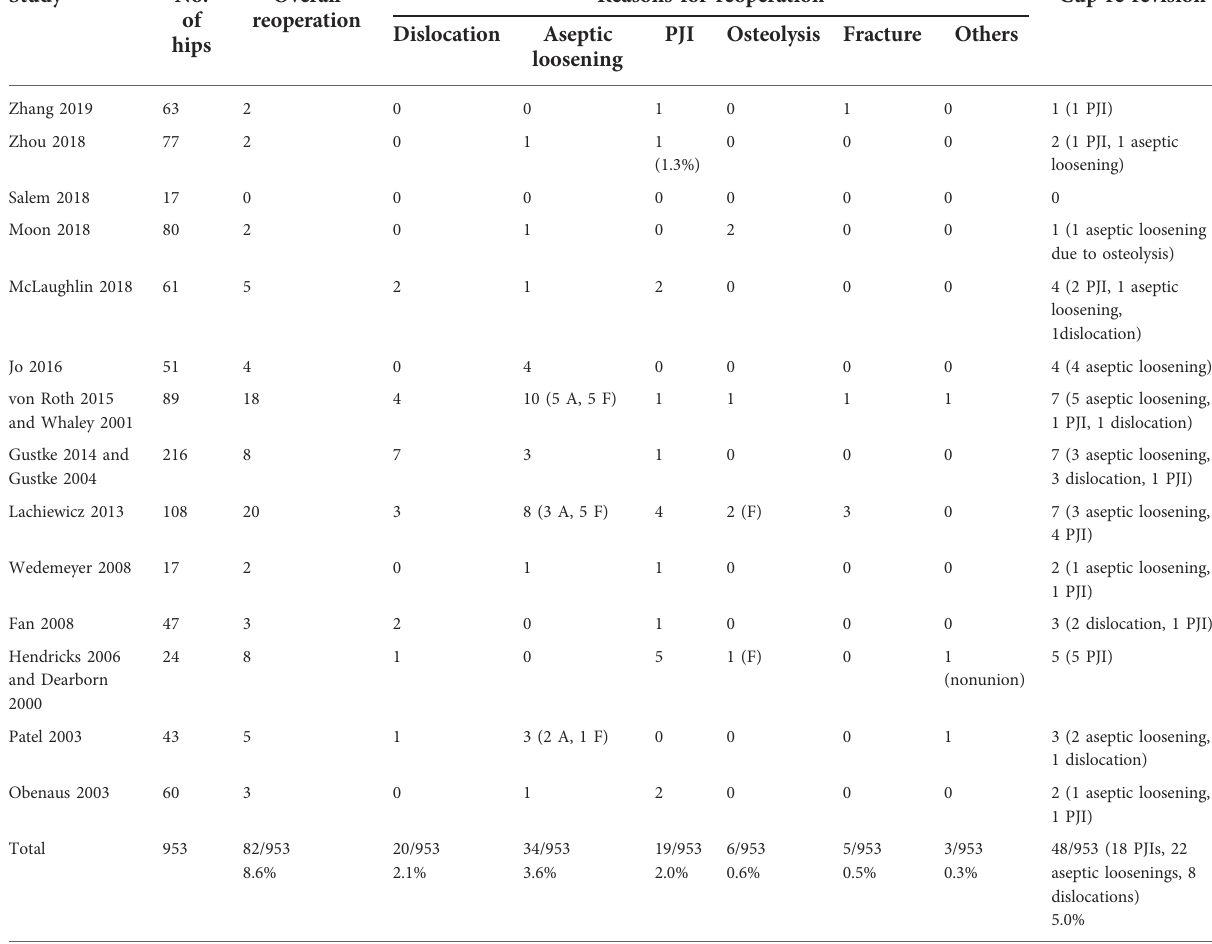
TABLE 5 Terms of reoperation and